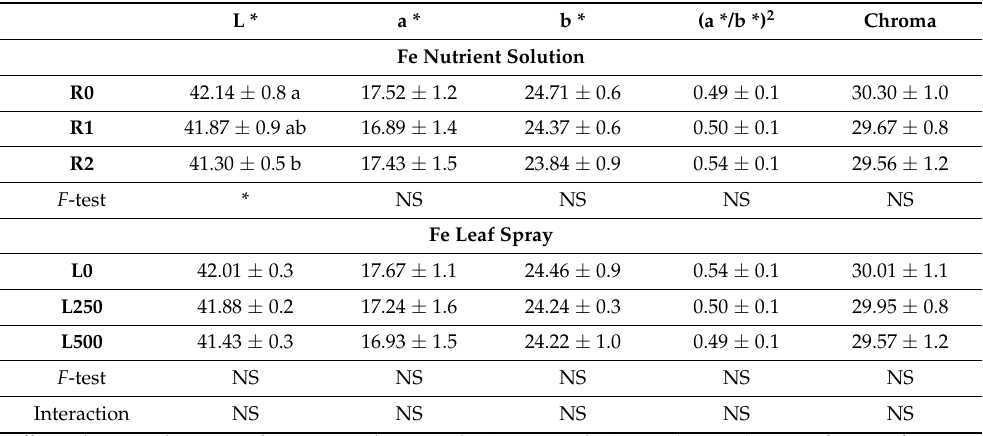
Table 2. Effects of Fe application on the chromatic coordinates of cherry tomato